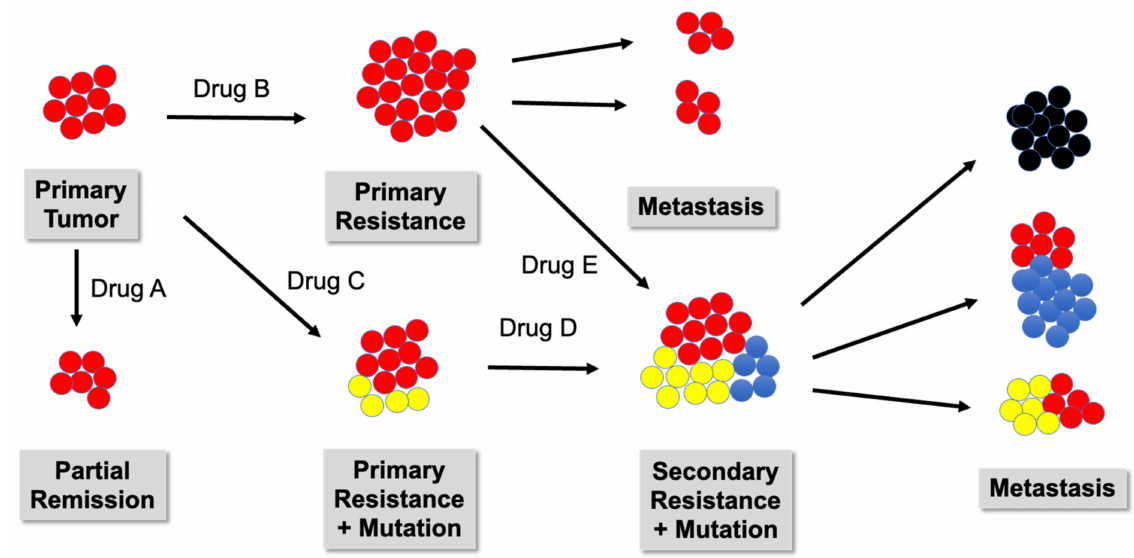
Figure 4. Development of cancer heterogeneity and formation of neoantigens. Treatment with a drug (A, B, C, D, or E) can result in cure, partial remission, or primary resistance that can progress to metastases and/or to mutation resulting in new cancer entities presenting neoantigens. Primary tumor: